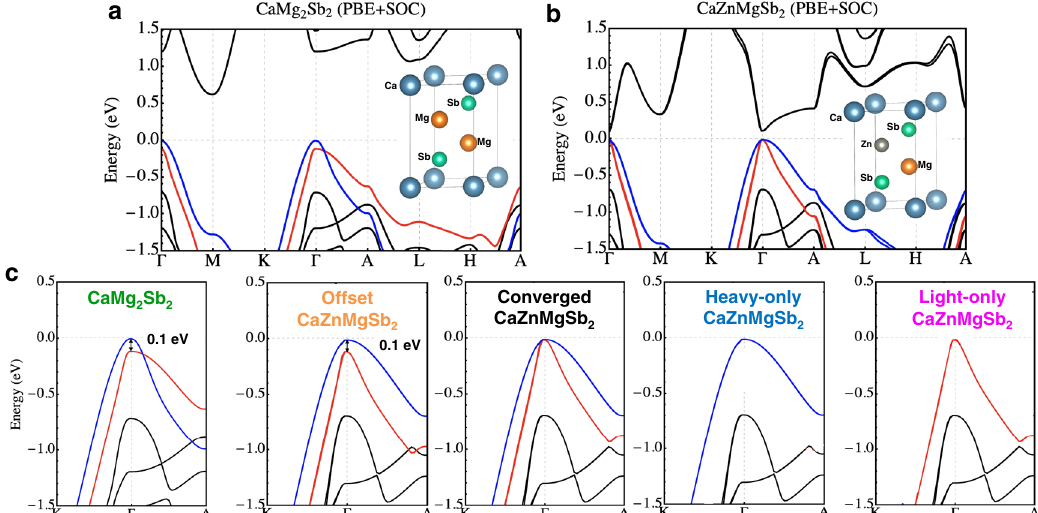
Fig. 1 DFT band structures calculated with PBE including SOC. a CaMg 2 Sb 2 and ( b ) CaZnMgSb 2 band structures, with their crystal structure insets. Perfect ordering of Zn and Mg is assumed of the latter. Note that the two bands are essentially converged at Γ for Zn:Mg = 1:1. c The fi ve band structure con fi gurations (including hypothetical CaZnMgSb 2 con fi gurations generated by manual adjustment of eigenvalues) subject to investigation via scattering and thermoelectric property